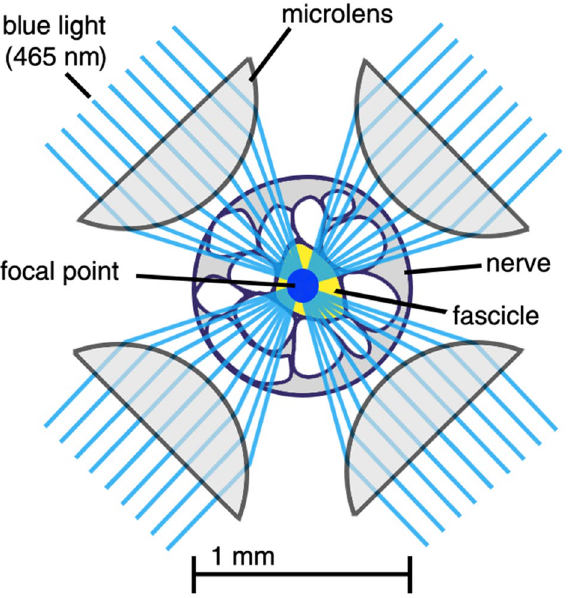
Figure 1. Cross-sectional view of multiple light sources with focused emissions converging on a common focal point; the cholinergic neurons in the fascicle at this location (yellow) are thereby stimulated. It is